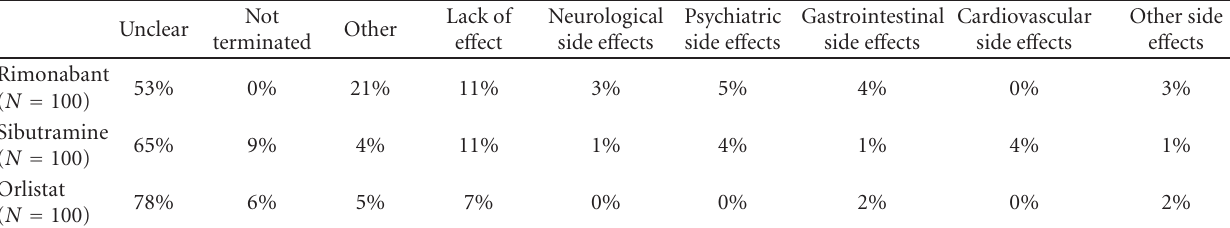
Table 3: Reasons for